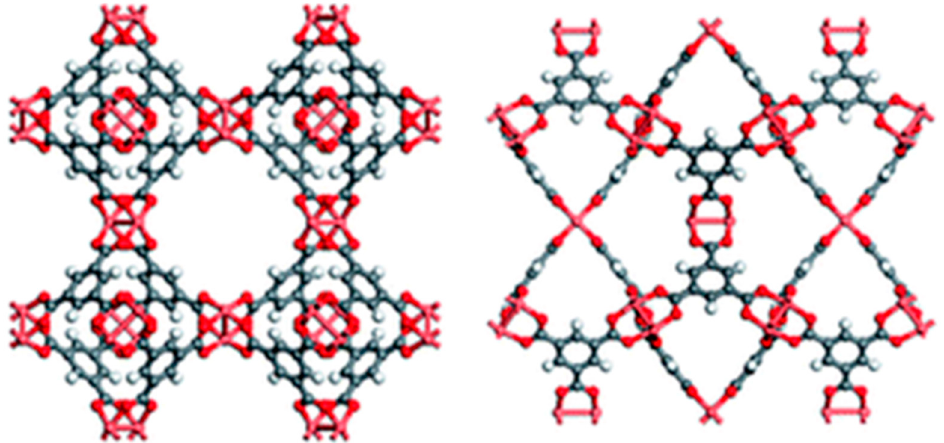
Figure 2. Cu-BTC metal–organic framework (MOF) viewed along two different axes to show the different pore structures. Adapted from a past study [11] with permission from The Royal Society of Chemistry.